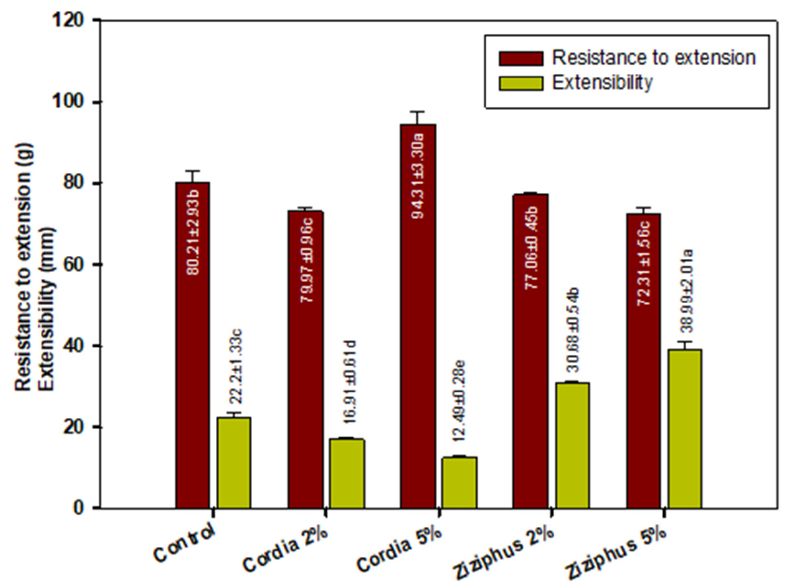
Figure 3. Dough extensibility properties of flour gum blends. Values followed by different letters in same color bars are significantly different at p ˂ 0.05.